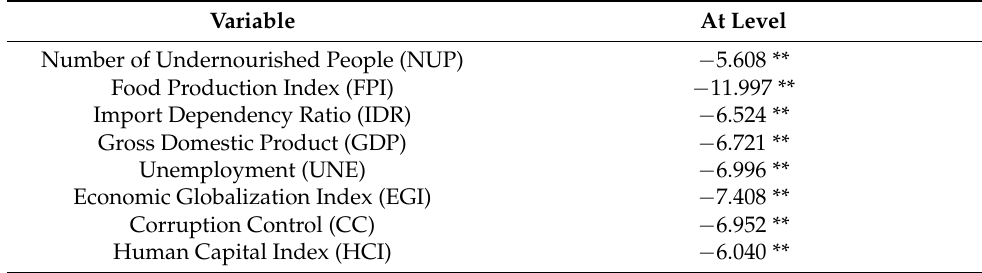
Table 2. ADF unit root test result for all variables in the model. Variable At